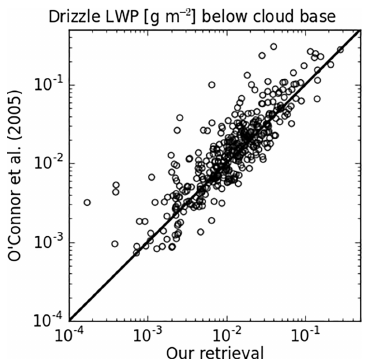
Figure 12. Comparison between the drizzle reflectivities at one range gate above and one range gate below the cloud base. The reflectivities above the cloud base are obtained from the Doppler spectral decomposition. The ones below the cloud base are simply the observed reflectivities. The diagonal line marks the one-to-one correspondence.